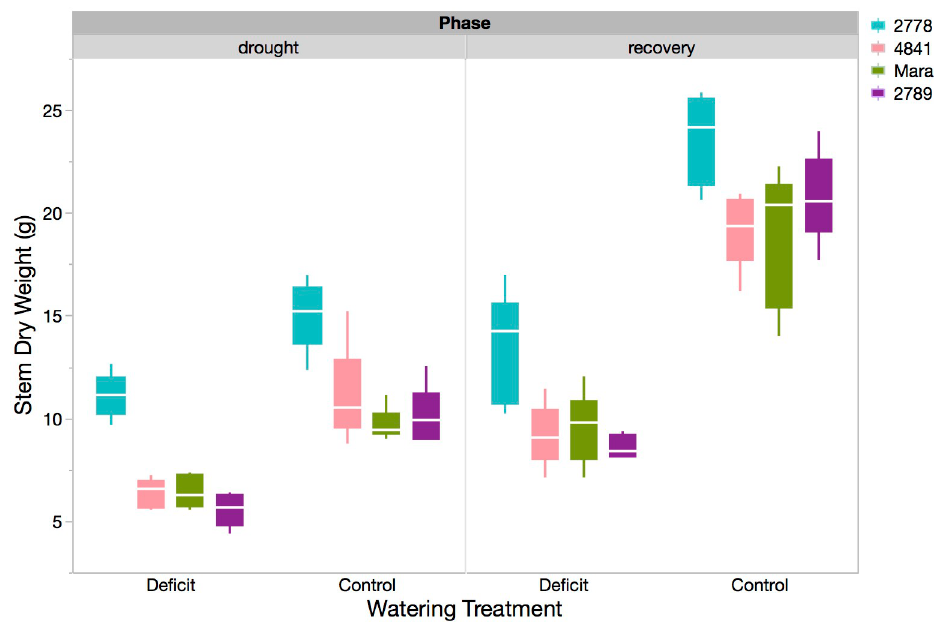
Fig 1. Box plot of stem dry weight (g) for each genotype in both the water stress and control treatments after re- watering recovery (right panel). The solid box contains the inner two quartiles, whereas whisker lines indicate 1.5 x IQR (3 rd quartile minus the 1 st quartile) from the box. The white horizontal line is the mean.